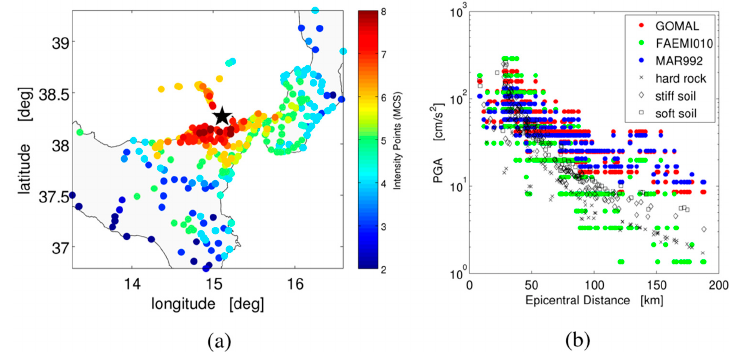
Figure 11. ( a ) Intensity points of the Mw = 6.0, 1978 Patti Gulf earthquake (DBMI15, [50]); ( b ) Comparison between the 1978 Patti Gulf earthquake scenarios (peak ground acceleration [PGA] versus epicentral distance) obtained using a set of relations between macroseismic intensity and PGA (GOMAL, [55]; FAEMI10, [56]; MAR992, [57]) and simulated by EXSIM for different soil categories (hard rock, stiff and soft